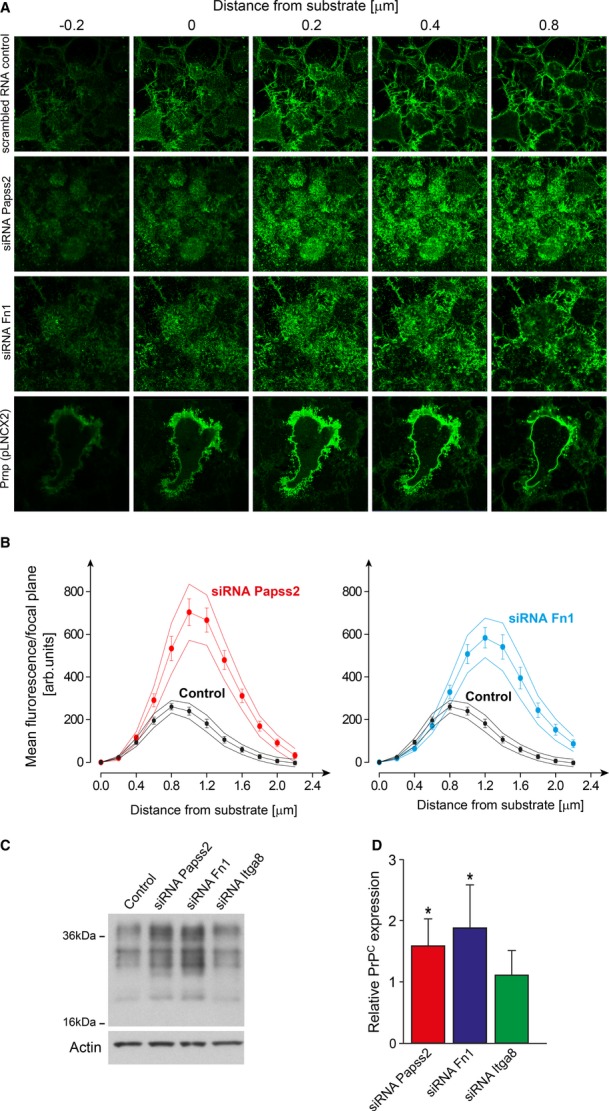
Phenotypic differences in PrPC densities at the ECM upon Papss2 and Fn1 loss of functionA Gene expression of Papss2 and Fn1 was silenced in R7 cells prior to immunolabelling with ICSM18. In addition, Prnp was overexpressed using pLNCX2 vector. Representative images of serial confocal z-stacks, acquired at identical laser setting, are shown.B Mean fluorescence intensities of Papss2- and Fn1-silenced cells labelled with ICSM18 and anti-mouse Alexa Fluor 488 antibodies were acquired according to the procedure described in Supplementary Fig S7. Mean fluorescence intensities of at least 40 intensity profiles ± standard error of the means, as well as upper and lower limits of 95% confidence intervals are shown.C, D PrPC protein expression levels in R7 cells at 3 days after transfection with siRNA against Papss2,Fn1, Itga8, and scrambled RNA control are shown (C) and quantified for three biological repeats with β-actin as an endogenous control (D; anti-actin, clone ACTN05 (C4), Abcam). Significant changes (P < 0.05) between gene silencing of candidates and scrambled RNA control are shown (*).